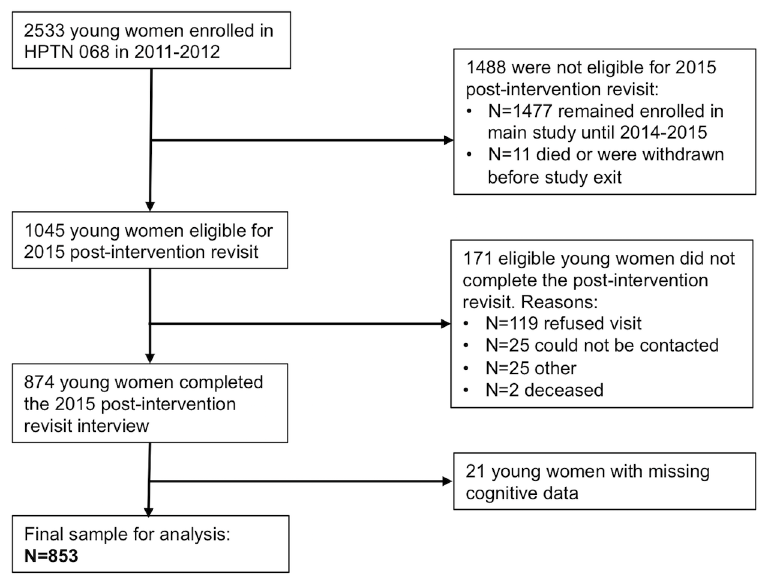
Fig 1. Flowchart of study sample